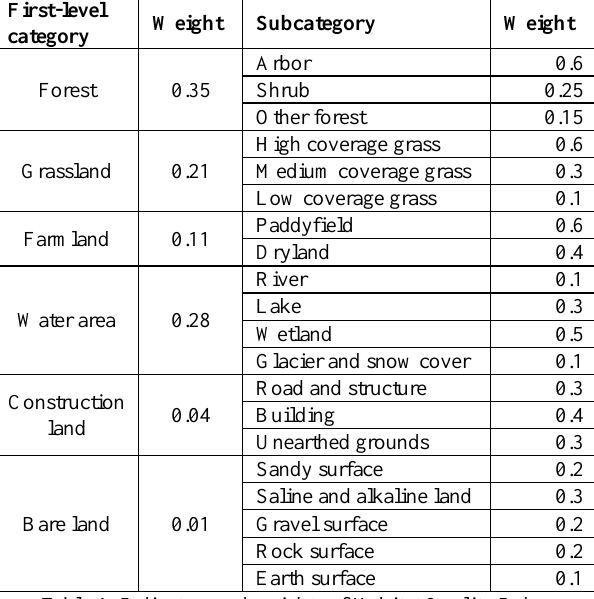
Table 1. Indicators and weights of Habitat Quality